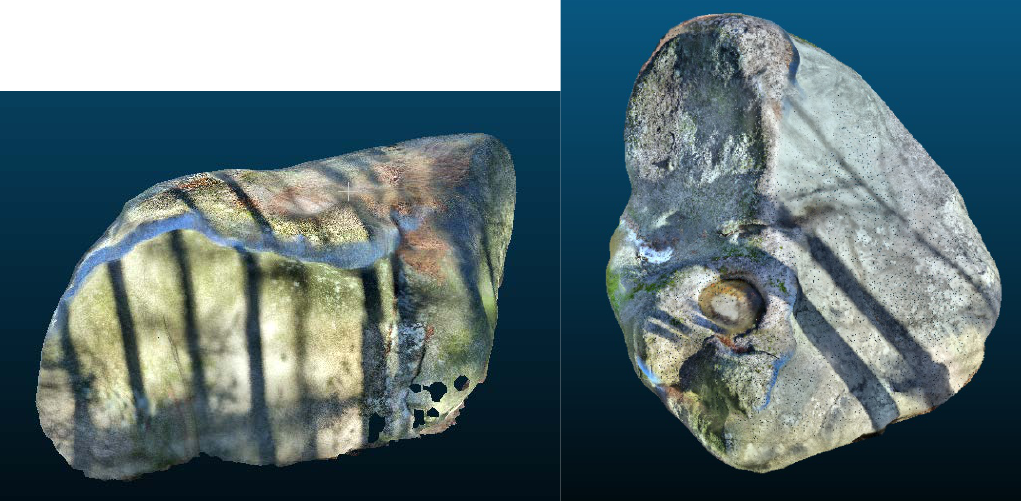
Figure 7 . Models created by 3DScanner for ArCore (Boulder No.1 – left, boulder No.2 – right) . Figure 7. Models created by 3DScanner for ArCore (Boulder No.1— left , boulder No.2— right ).